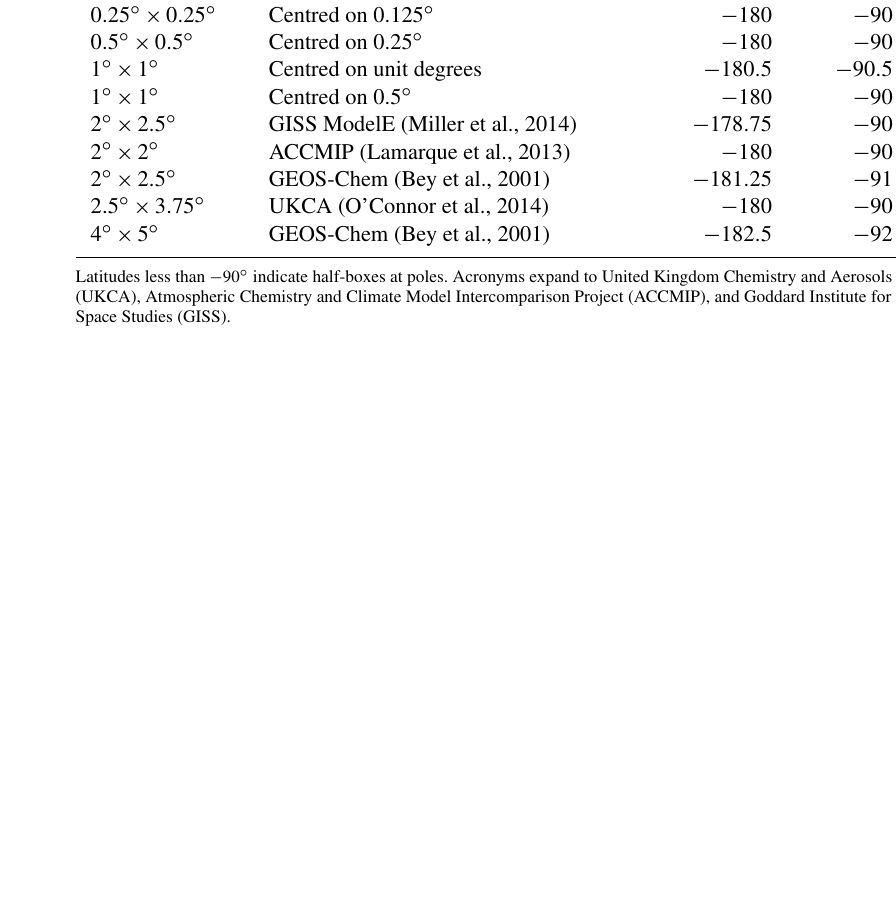
Table A4. Spatial and temporal resolutions of global monthly iodide fields available for download from the United Kingdom’s Centre from Environmental Data Analysis (Sherwen et al., 2019; https://doi.org/10/gfv5v3). Re-gridding was performed in Python using the open-source xESMF package (Zhuang, 2018). Resolution Bottom-left grid edge Lat. × long. Model/description Long.